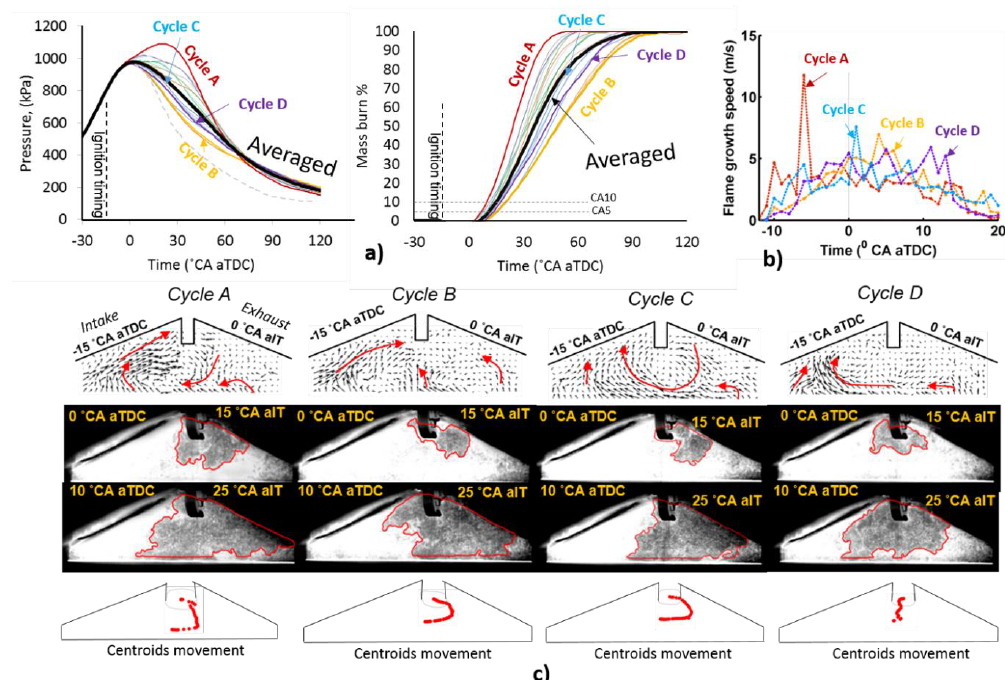
Figure 12. ( a ) In-cylinder pressure and burnt duration of 19 tested cycles with combustion PIV, ( b ) the flame velocity of the four selected cycles derived from the extracted flame front and ( c ) flow-field vectors at the ignition timing of the four selected cycles and the flame development at 0 ◦ and 10 ◦ CA aIT as well as the movement of the corresponding flame centroids over the whole inspected period.